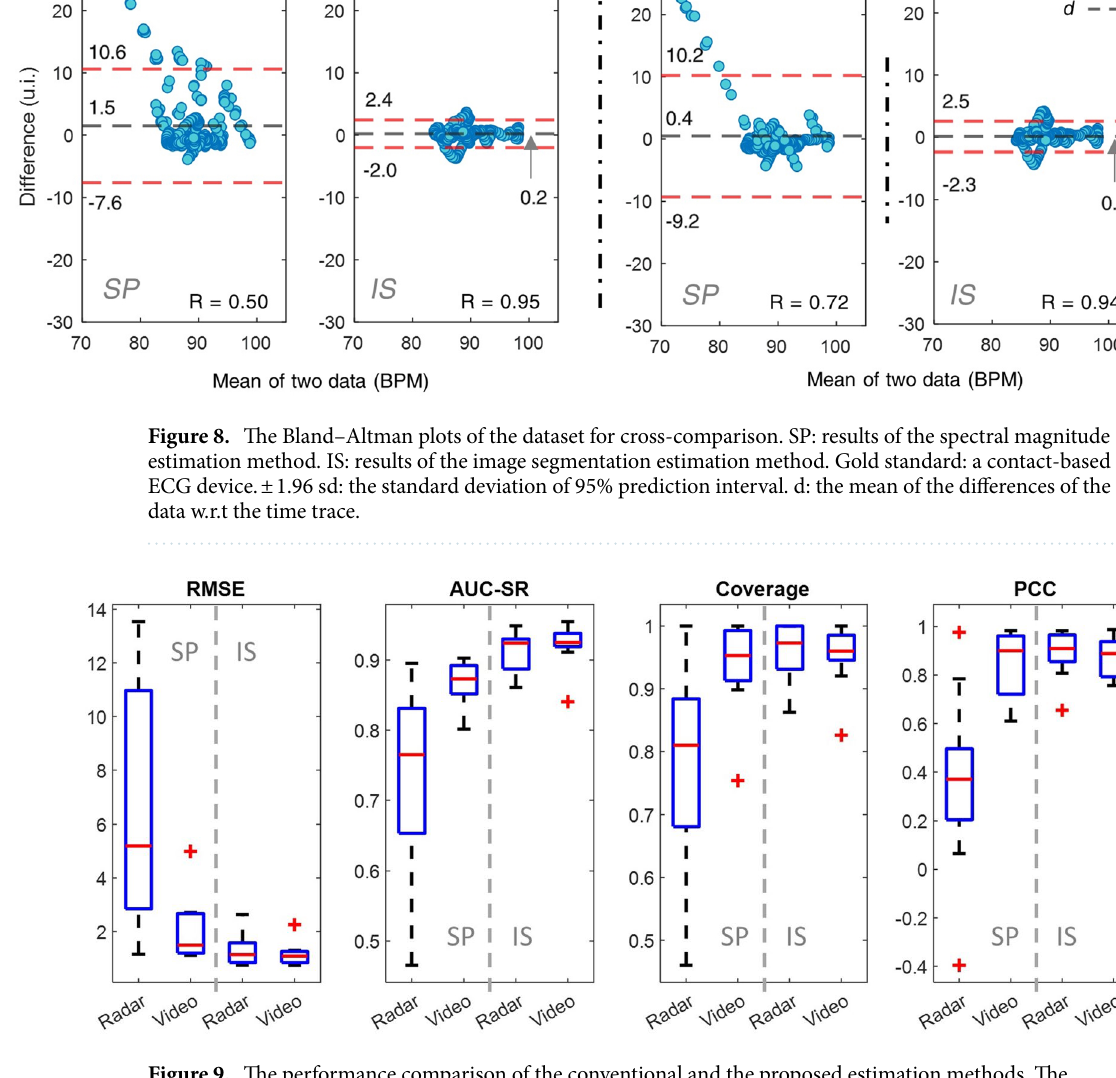
Figure 9. The performance comparison of the conventional and the proposed estimation methods. The boxes on the SP side represent the evaluations of the spectral magnitude method, IS represents the image segmentation method. The median values are indicated by red horizontal bars inside the boxes, the 25 and 75% quartile range by boxes, and the full range by whiskers. Red plus marks represent the